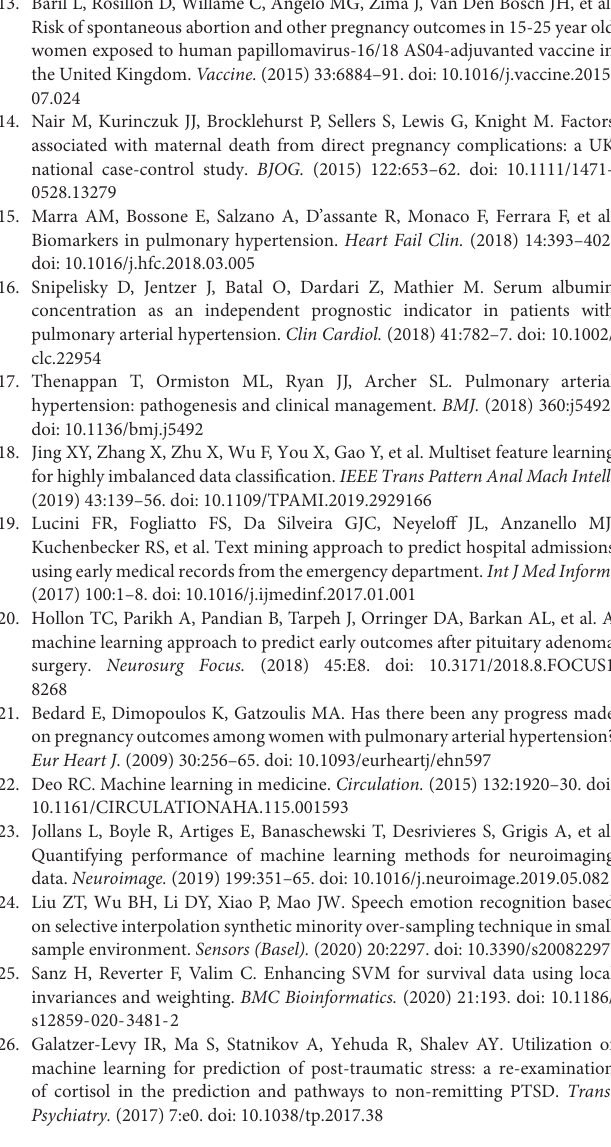
Organization; PH, pulmonary hypertension. Supplementary Table 1 | Echocardiographic signs suggesting pulmonary hypertension used to assess the probability of pulmonary hypertension in addition to tricuspid regurgitation velocity measurement. Supplementary Table 2 | Feature importance across 5-fold